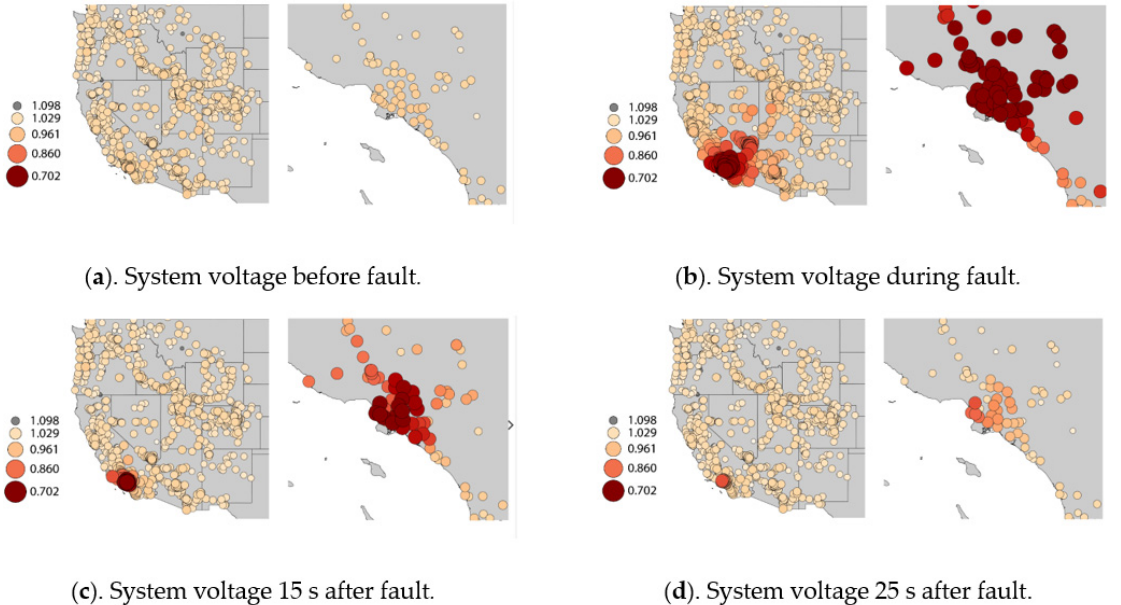
Figure 6. Modeled US Western Interconnection node voltages and inset Greater Los Angeles Basin for a fault occurring near San Bernardino, CA, USA.